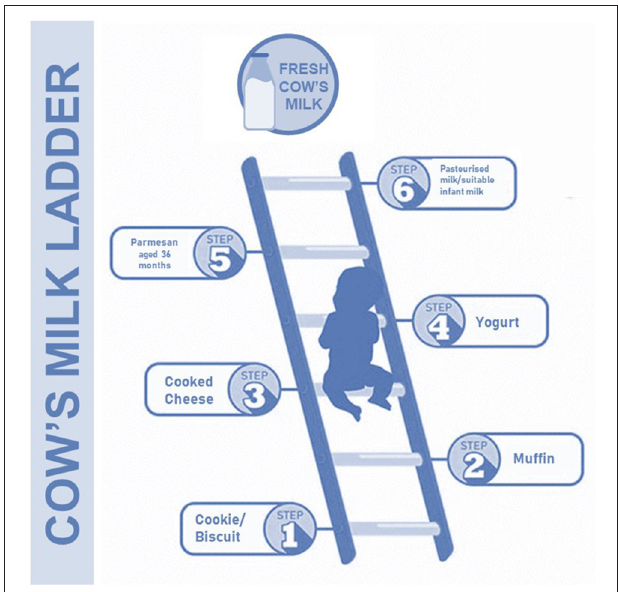
FIGURE 2 | The cow’s milk ladder approach. This step-by-step approach from fewer to more allergenic milk forms could speed up the immune tolerance acquisition in children with CMA.